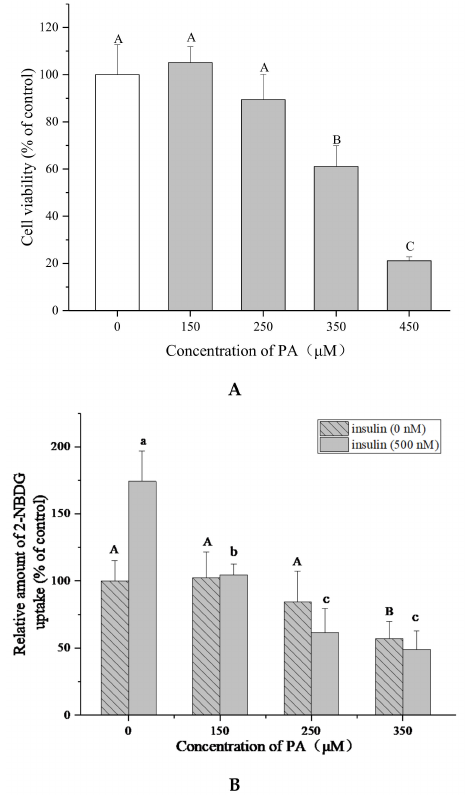
Figure 3. Palmitic acid (PA) induces IR in HepG2 cells. ( A ) Effect of PA on HepG2 cell growth at 24 h. Cell viability was determined by MTT assay. ( B ) PA reduces 2-NBDG uptake of HepG2 cells with or without insulin (500 nM). Data are represented as means ± SD from five replicates. Significant differences between different treatments are showed by different letters ( p < 0.05).